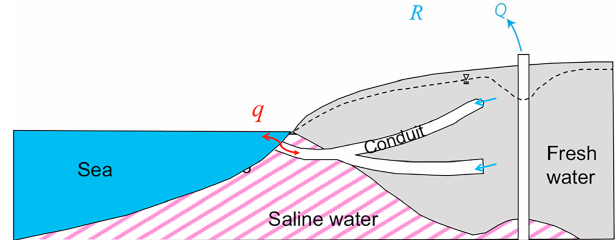
Figure 2. Schematic figure of a coastal karst aquifer with conduit networks and a submarine spring opening to the sea in a cross sec- tion. Flow direction q would be seaward when sea level drops, pumping rate Q is low, and precipitation recharge R is large; how- ever, reversal flow occurs when sea level rises, pumping rate Q is high, or precipitation recharge R is